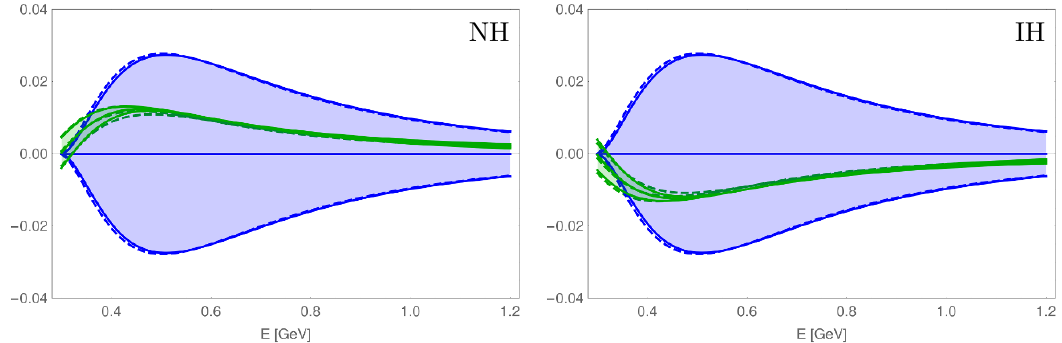
Figure 7 . CPT-odd (green) and T-odd (blue) components of A CP as functions of the neutrino (cid:22)e energy E through the Earth mantle (of constant density) at T2HK baseline L = 295 km. Both the exact (dashed) and the analytical (solid) results from eqs. (3.25) are shown. Normal/Inverted Hierarchy in the left/right pannel. The bands correspond to all possible values changing (cid:14) in (0 ; 2 (cid:25) ); the upper/central/lower lines for A CPT ( A T ) correspond to cos (cid:14) (sin (cid:14) ) = (cid:0) 1 ; 0 ; (cid:22)e (cid:22)e